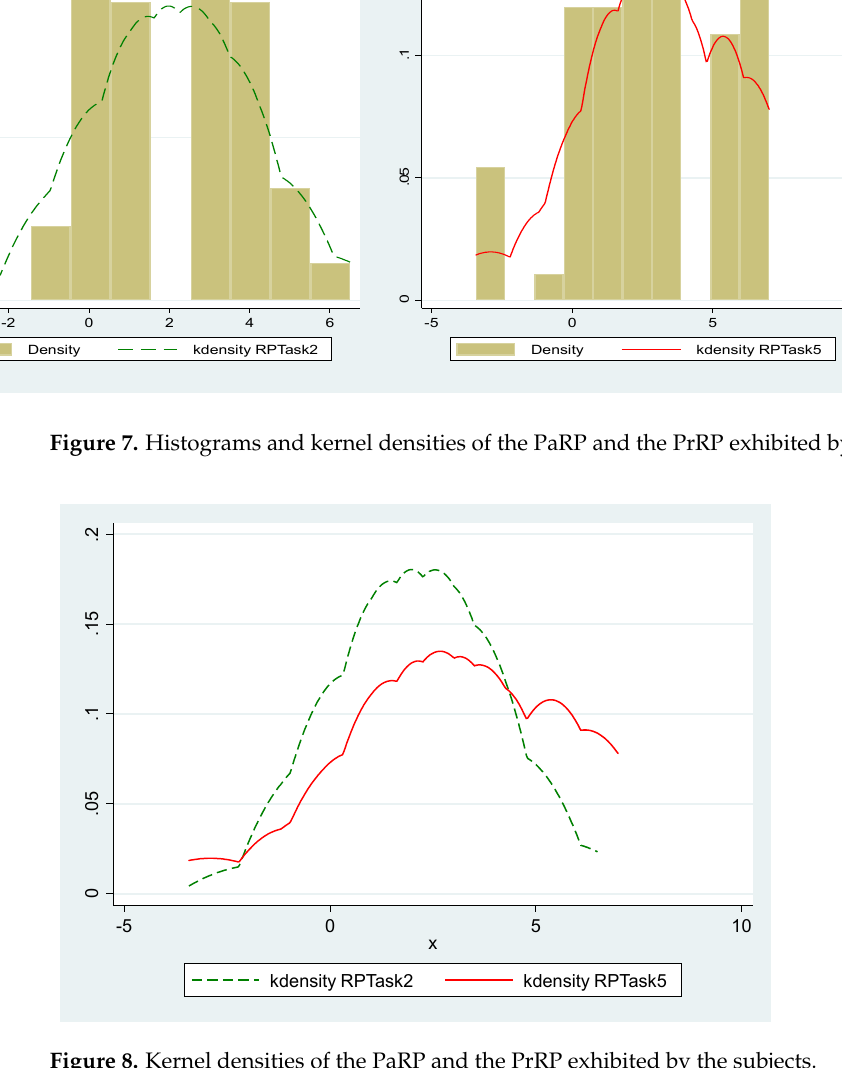
Figure 8. Kernel densities of the PaRP and the PrRP exhibited by the subjects. The results from this section indicate that the RPs inferred from a task with uncertain payoffs are greater than those inferred from a task with uncertain payoffs. More specifically, the average of the PaRPs for the sample under study is USD 2.10 (i.e., 19.1% of the EV), while the average of the PrRPs is USD 3.05 (i.e., 27.7% of the EV). This is lotteries with payoff odds (PaCE) is greater than that for lotteries with price odds (PrCE).